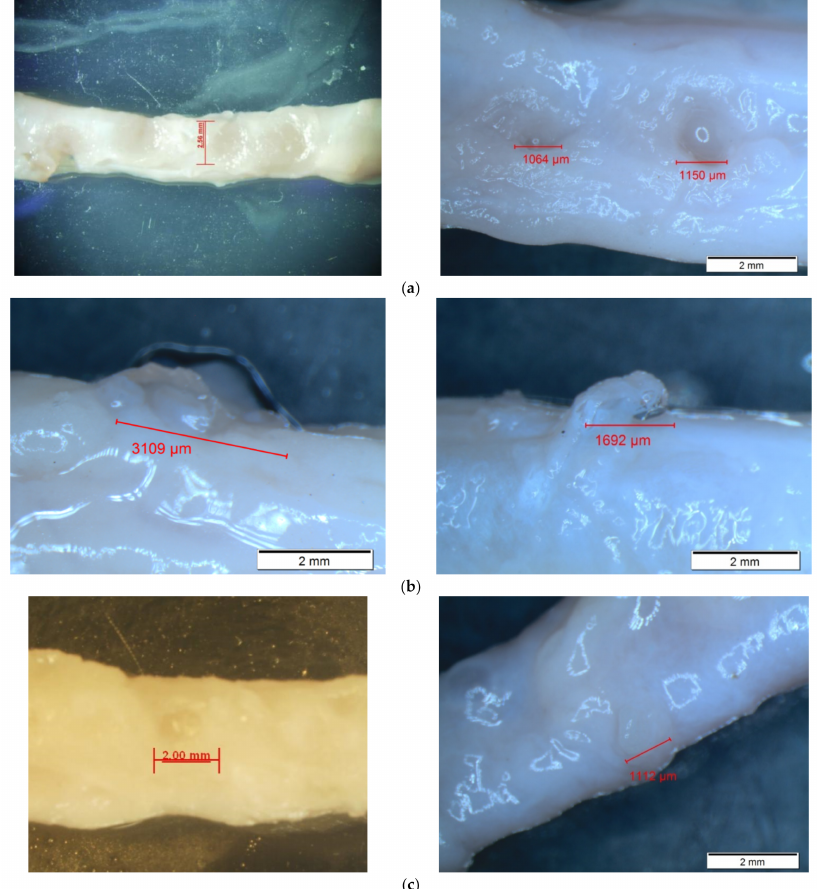
Figure 4. Representative images of HIFU-induced morphological changes to the artery wall with the HIFU focus aligned to ( a ) the anterior artery wall, ( b ) the middle of the artery, and ( c ) the posterior artery